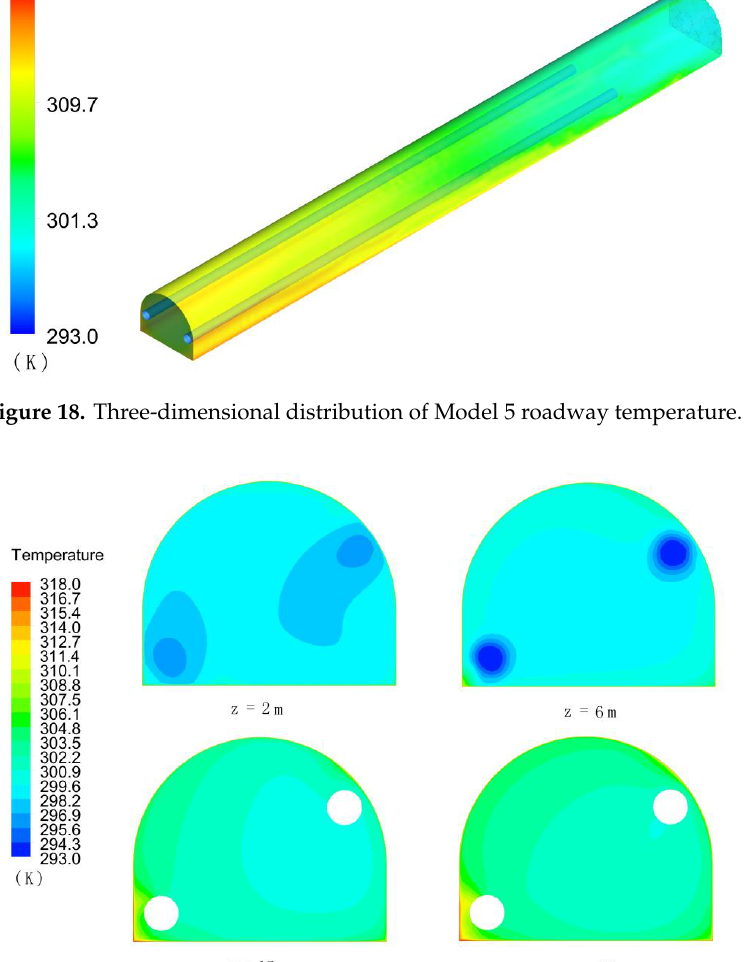
Figure 19. Model 6 section temperature distribution.